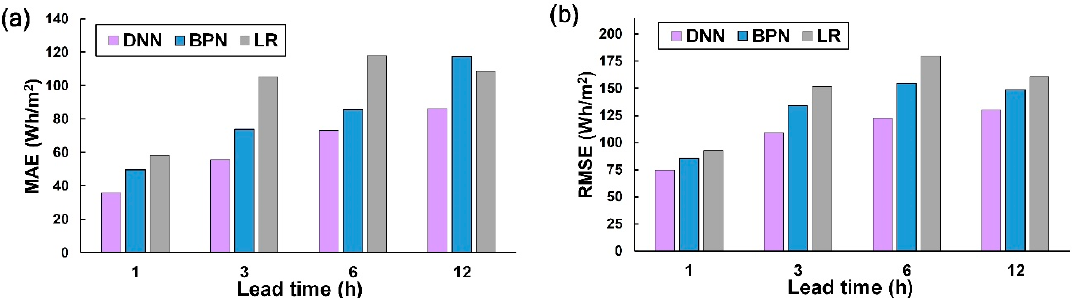
Figure 8. Solar radiation prediction performance: ( a ) mean absolute error (MAE) and ( b ) root mean square error (RMSE).